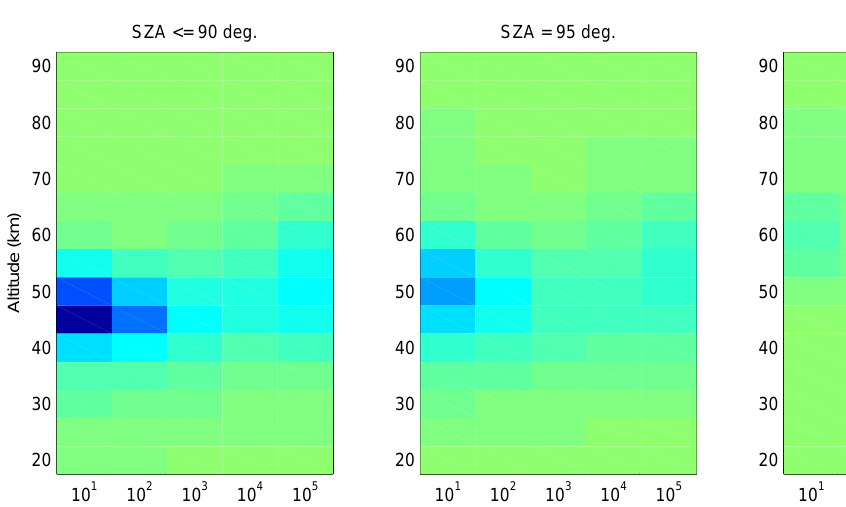
Fig. A21. P NO /Q for October